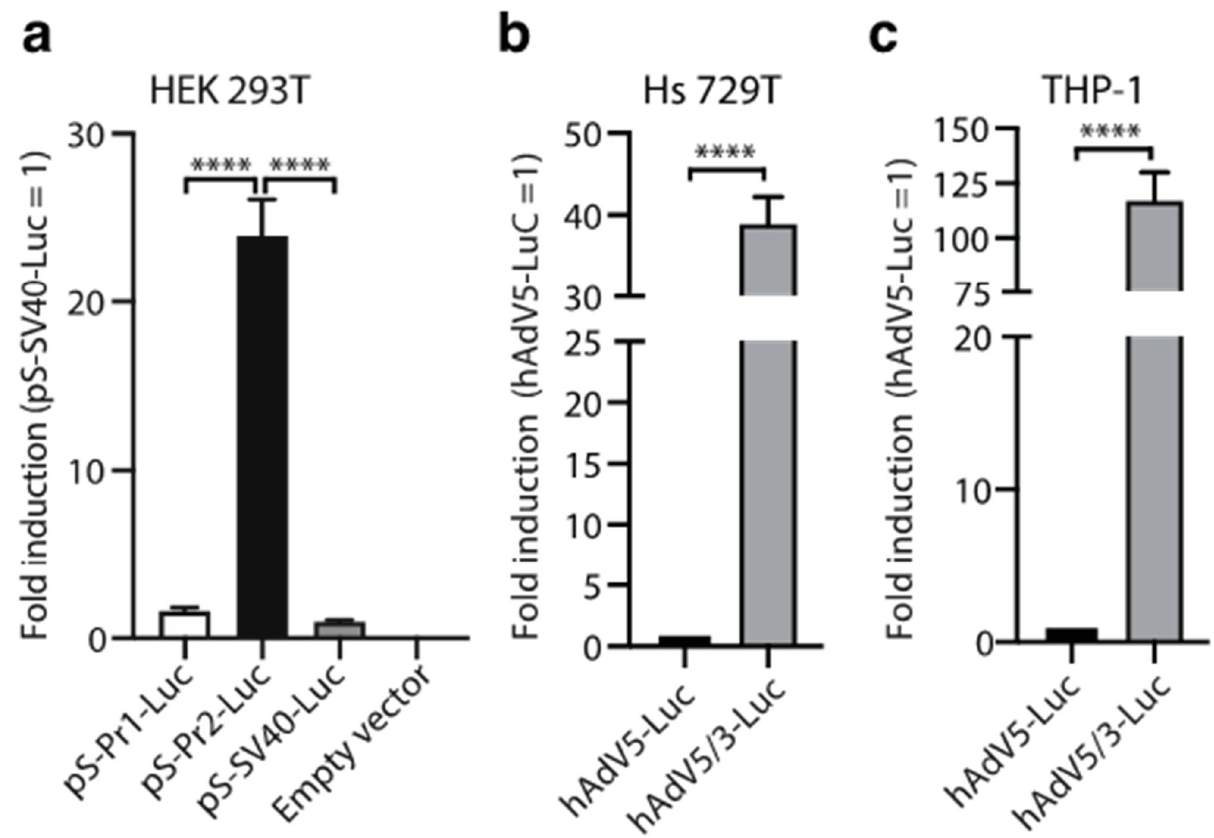
Figure 1. Luciferase expression following cell transfection or transduction with adenoviral vectors. ( a ) HEK293T cells were transiently transfected with plasmidic vectors encoding for different candidate promoters upstream of luciferase. An empty vector was included as a control. The promoter activity was evaluated by luminescence, using a luciferase gene reporter assay. The relative firefly luciferase units were normalized by renilla and expressed as fold induction over the SV40 promoter. The bars represent means ± SEM ( n = 3). **** p < 0.0001; one-way ANOVA. ( b , c ) Hs 729T and THP-1 were transduced with the replication-deficient adenoviruses, hAdV5-Luc or hAdV5/3-Luc. Luciferase activity was determined 48 h post-transduction. The results are expressed in relative luciferase units (RLU) of Firefly Renilla normalized to hAdV5-Luc. The bars represent means ± SEM ( n = 3). **** p < 0.0001; Student’s t -test.